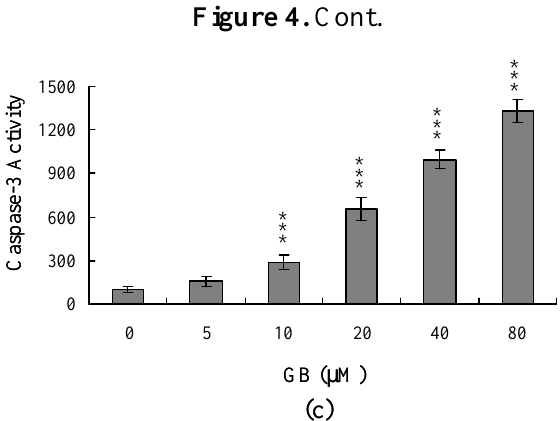
Figure 5. NO involved in ginkgolide B-induced apoptotic biochemical changes in MCF-7 cells. Cells were pretreated with PTIO (20 µ M) for 1 h and then treated with ginkgolide